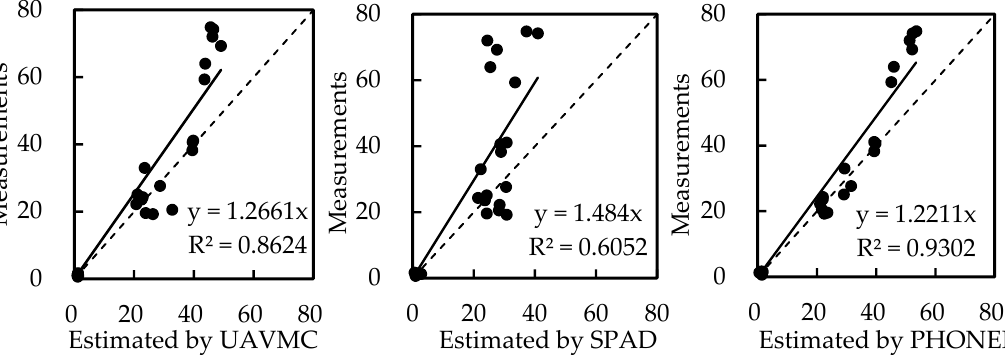
Figure 5. Correlations between nitrate nitrogen content in the 0–90 cm soil layers (mg/kg) obtained by the laboratory testing method and estimated by the methods of UAVMC, SPAD, and PHONEP.